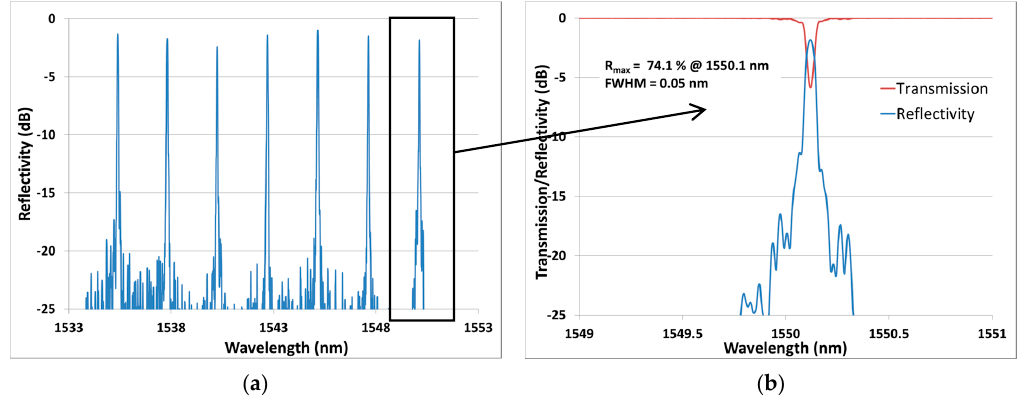
Figure 11. ( a ) Reflectivity spectrum of an array of seven FBGs (L = 25 mm) spectrally spaced by ~ 2.5 nm written in a Fibercore SM1500(9/125)P. ( b ) Zoom on the transmission and reflectivity spectra of one FBG.